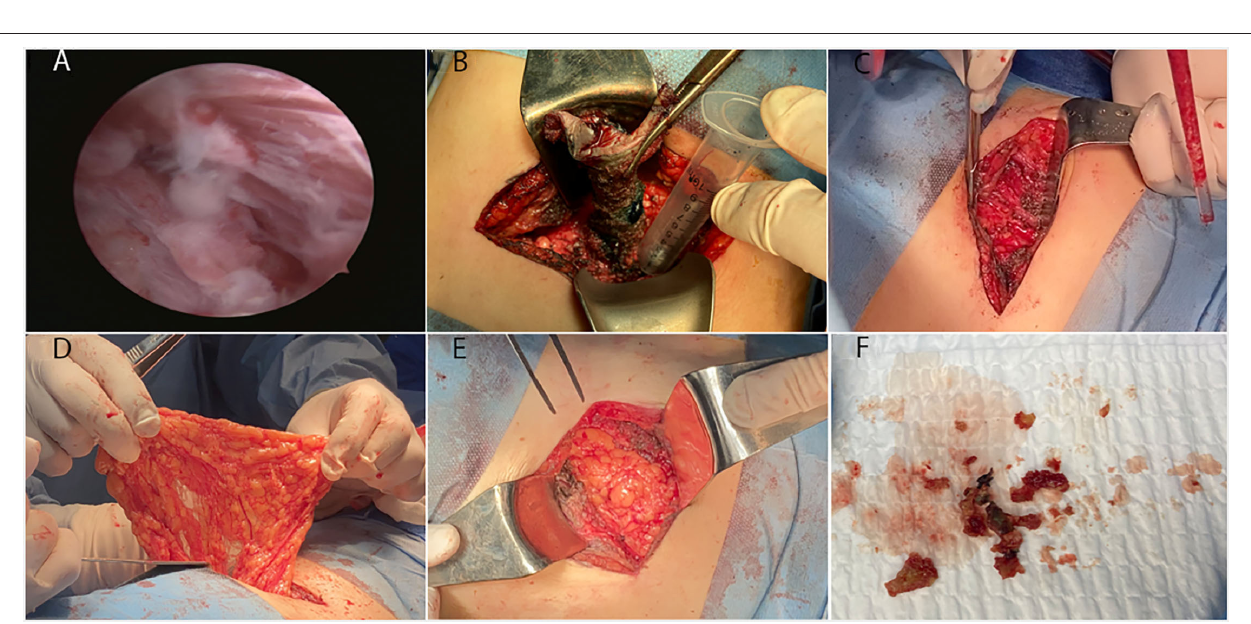
FIGURE 1 | The general view and CT images of the nephrocutaneous fistula (NCF). (A,B) The fistula was 0.5 x 0.5cm size and 6cm deep on his left flank. (C) Abdominal CT showed the sinus tract (red arrow), extending from the surface of left kidney near the lower upper pole to the skin without renal/ureteral stone or hydronephrosis. (D,E) We injected contrast media into the sinus tract from the skin opening under pressure. The direction of the sinus tract is shown by the red arrow. (F–H) The three-dimensional reconstruction showed the relationship between the sinus tract and the left kidney. The sinus tract was marked green. We can see that the bottom of the sinus tract was closely connected with the lower pole of the left kidney.